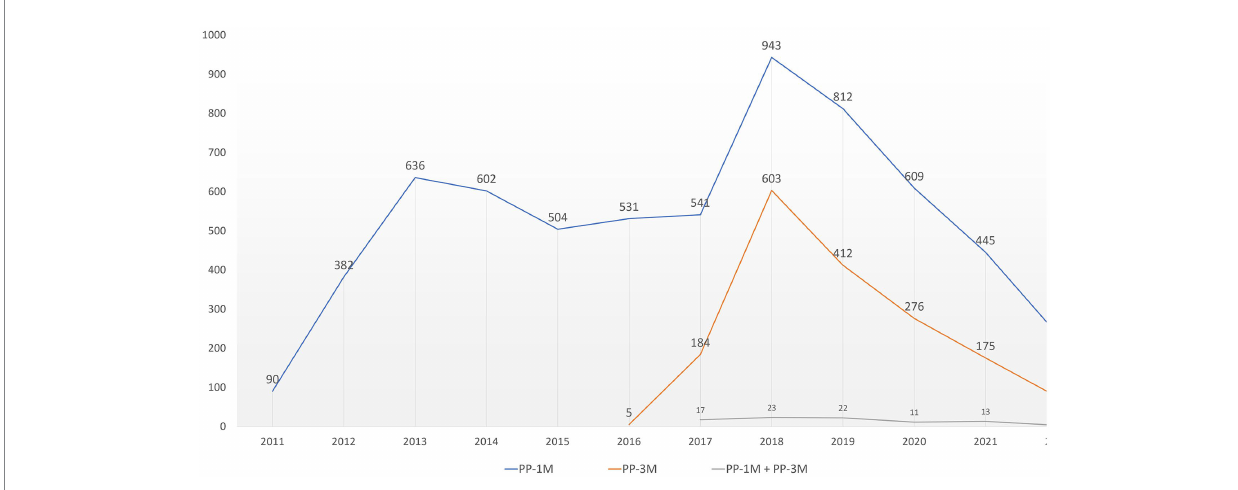
FIGURE 1 PP-related ICSRs temporal distribution. ICSRs, Individual Case Safety Reports; PP, paliperidone palmitate; PP1M, paliperidone palmitate 1-month; PP3M, paliperidone palmitate